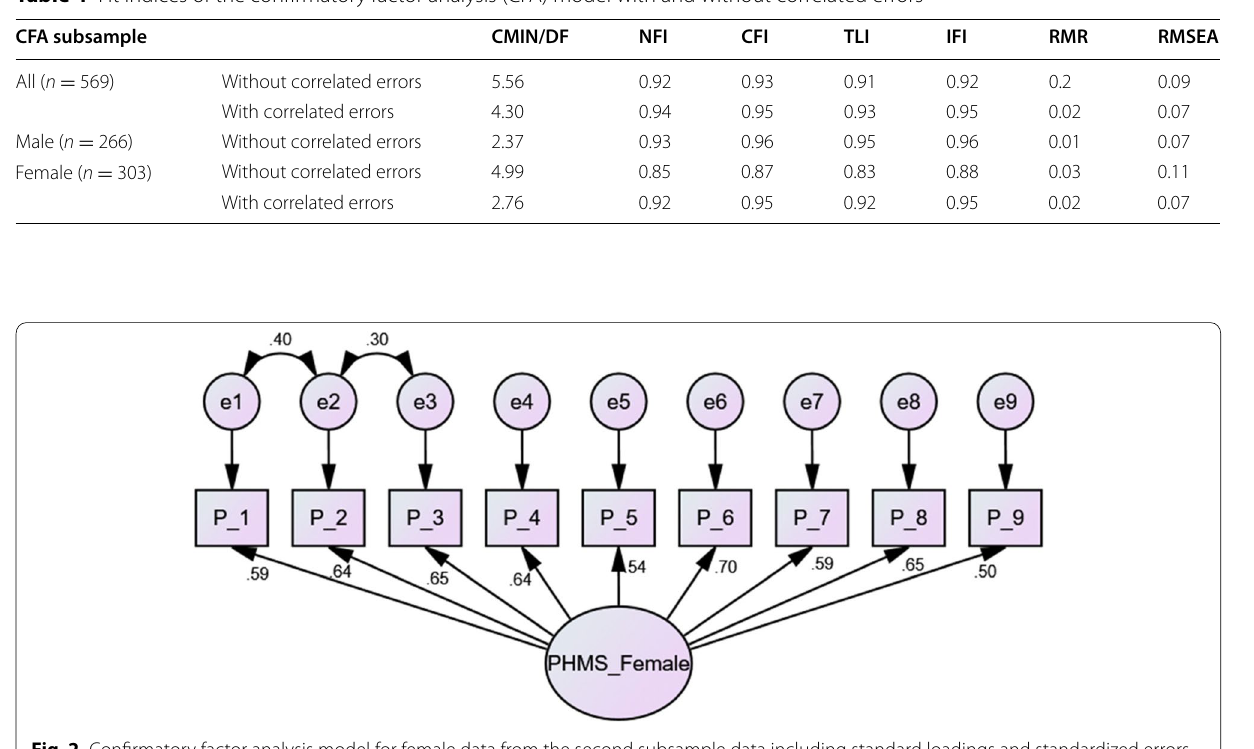
Fig. 2 Confirmatory factor analysis model for female data from the second subsample data including standard loadings and standardized errors.